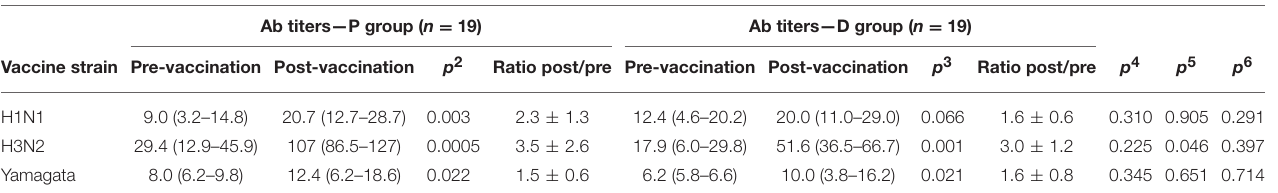
TABLE 2 | Antibody response to inactivated influenza virus vaccine in all volunteers 1 . Ab titers—P group ( n = 19) Ab titers—D group ( n = 19)